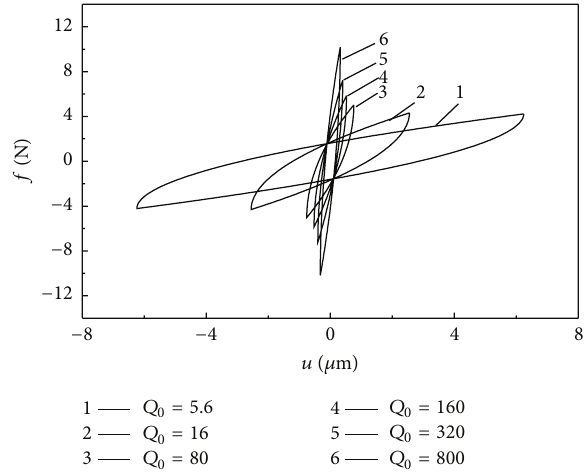
Figure 9: Resonance hysteresis loops of dry friction blade with lacing wire.